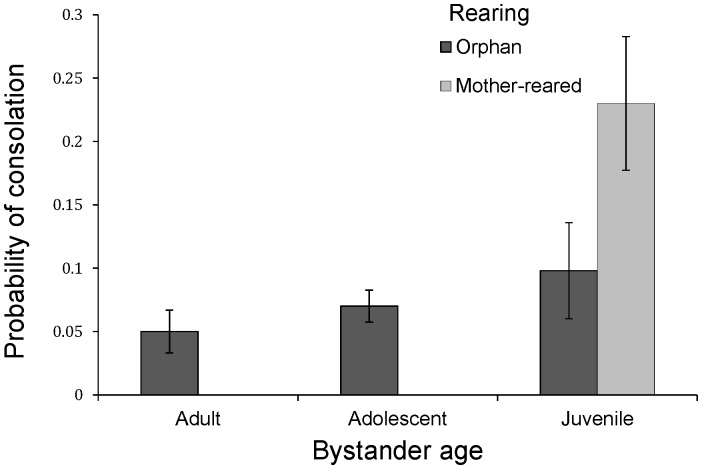
The effect of bystander age and rearing on providing consolation to victims of aggression.The graph provides the mean+SEM proportion of conflicts per individual to which they were bystander. Corresponding GLMM models revealed significant effects of both bystander age and rearing (significant differences between juveniles vs adults, adolescents vs adults, mother-reared vs orphans, see Table 2). The asterisk indicates P<0.05.